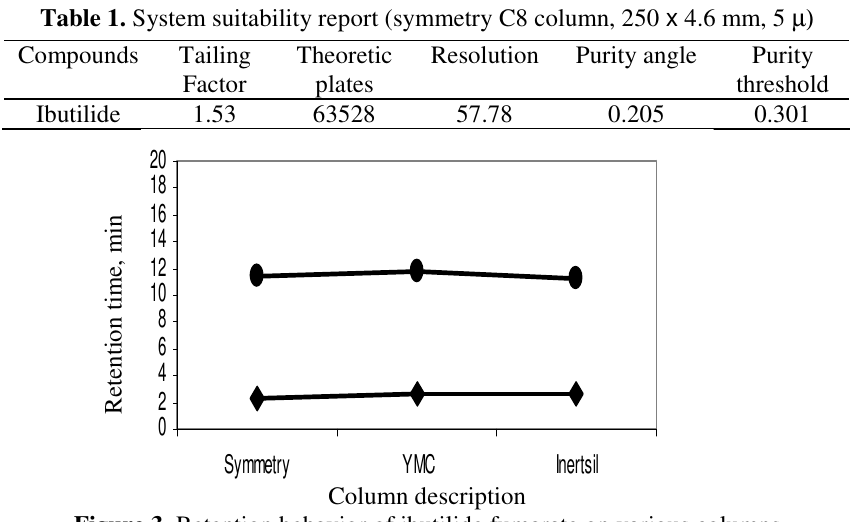
Figure 3. Retention behavior of ibutilide fumarate on various